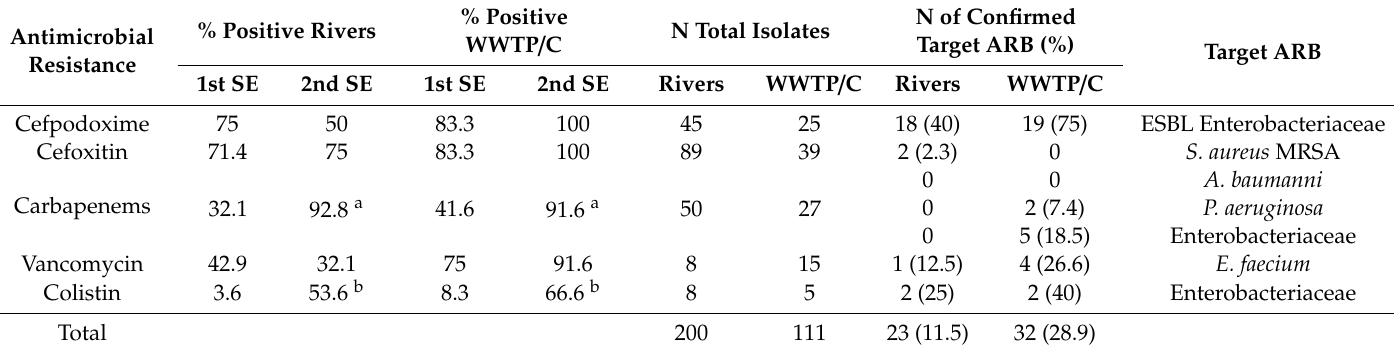
Table 4. Percentage of positive rivers and WWTPs and collectors for each antibiotic in both sampling events and the number of resistant strains isolated. % Positive N of Confirmed % Positive Rivers N Total Isolates Antimicrobial WWTP / C Target ARB Resistance